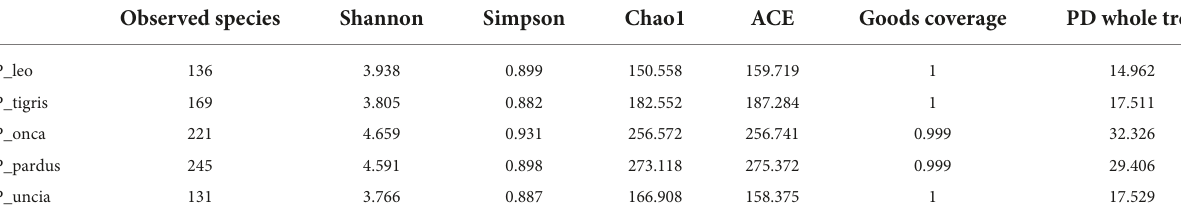
TABLE 2 Alpha diversity indices of Panthera animals’ intestinal microbiota (mean